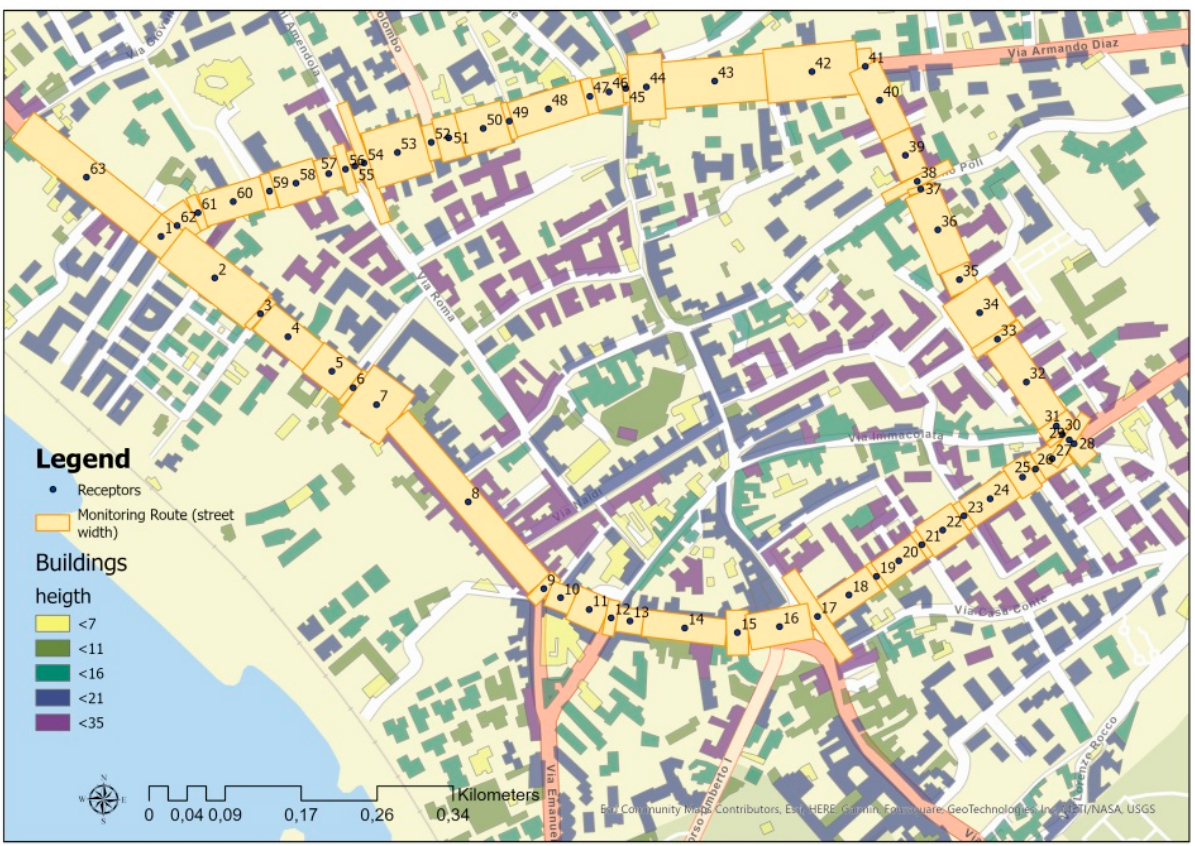
Figure 4. Map of the receptor points and the polygon street segments at which SIRANE associates